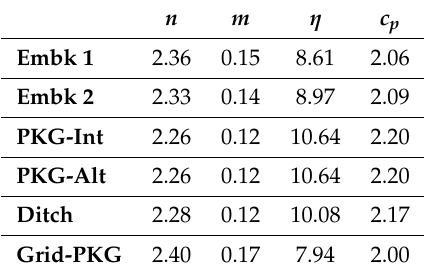
Table 3. Hydraulic shape parameters ( n , m , and η ) and shape parameter function c p .